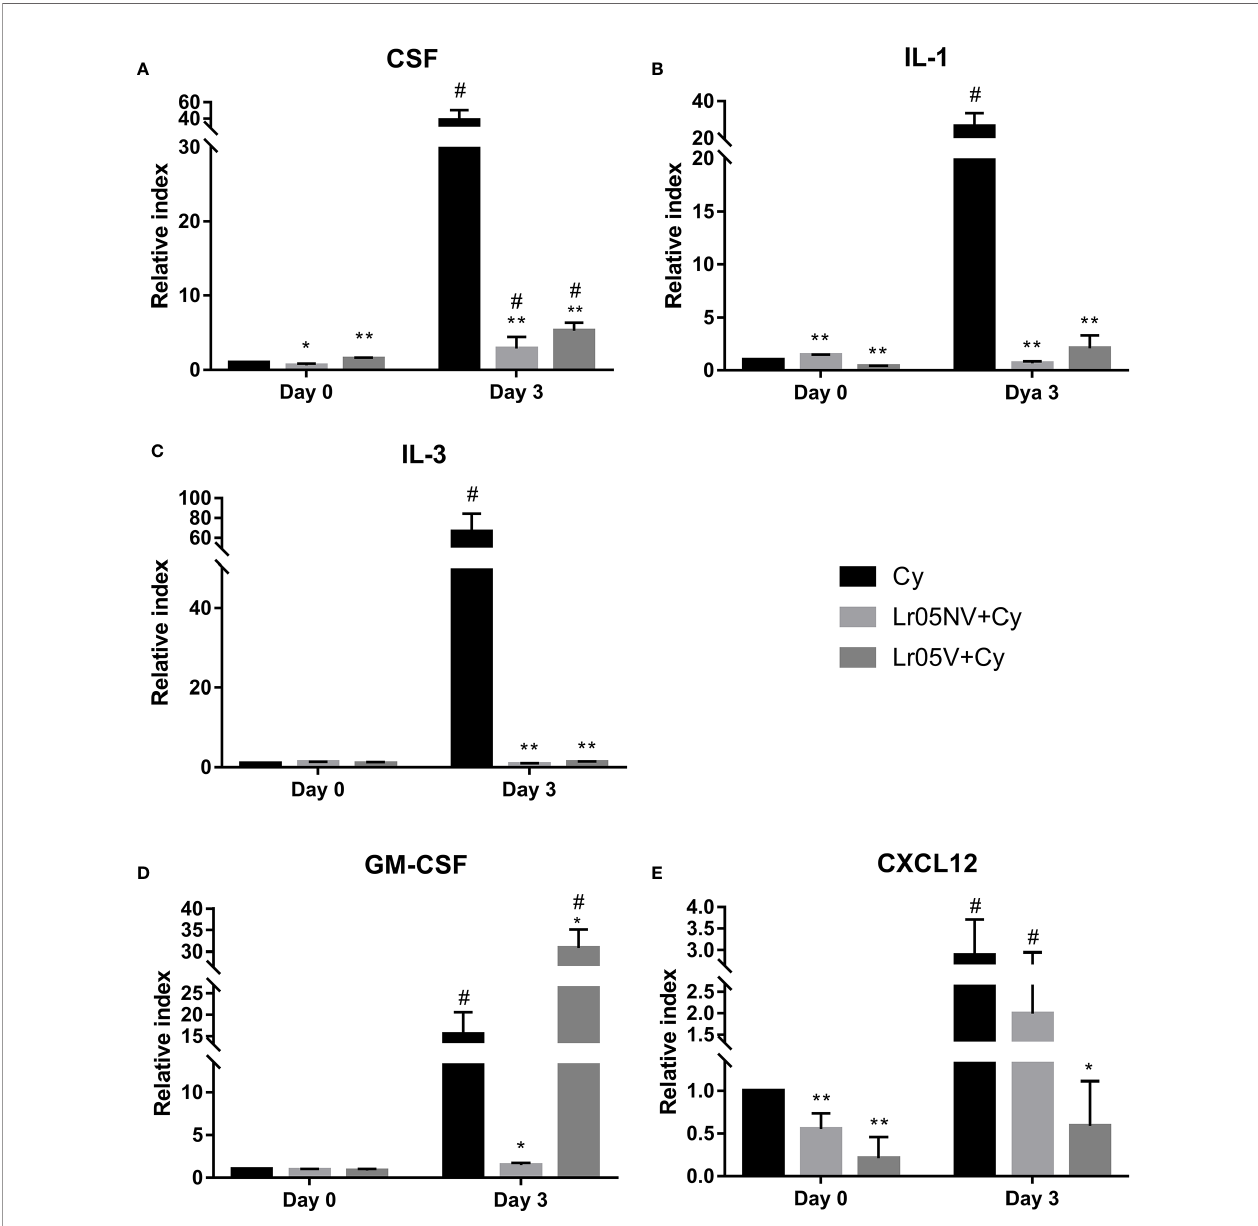
FIGURE 7 | Expression of hematopoietic growth factors and cytokines in bone marrow. 6-week-old Swiss mice were fed with 10 8 cells/mouse/day of viable or non- viable Lactobacillus rhamnosus CRL1505 (Lr05V+Cy or Lr05NV+Cy groups) for 5 consecutive days before injection of Cy. The treated groups and the untreated control mice (Cy group) received one dose of 150 mg/kg Cy intraperitoneally. Levels of mRNA of bone marrow CSF (A) , IL-1 b (B) , IL-3 (C) , GM-CSF (D) , and CXCL12 (E) were performed on day 0, before Cy administration, and day 3 post-Cy administration. The results come from two independent experiments. Six animals per group each time were used in the experiments. Results are expressed as mean ± SD. **,* Signi fi cant differences from the Cy group should be as follows (p<0.0001 or p<0.0002 respectively). # Signi fi cant difference from the Cy group on day 0 should be as follows